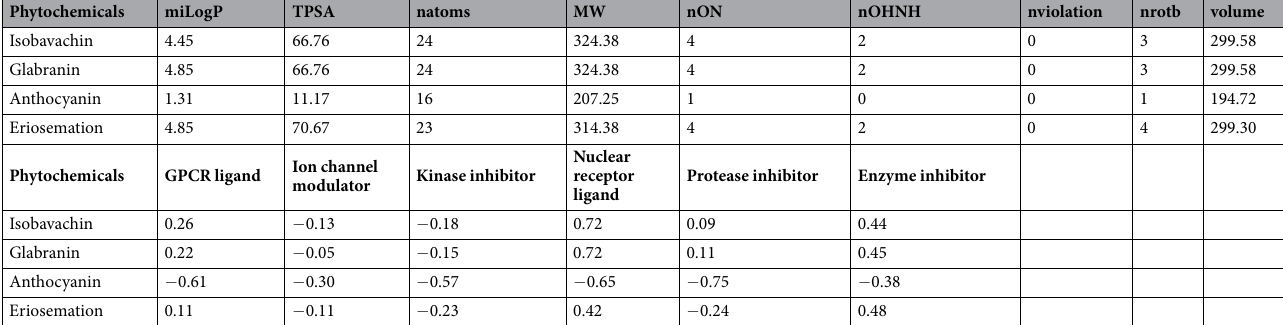
Table 4. ( a ) The Lipinski’s rule of five attributes of shortlisted phytochemicals. ( b ) Molinspiration bioactivity score of shortlisted phytochemicals.